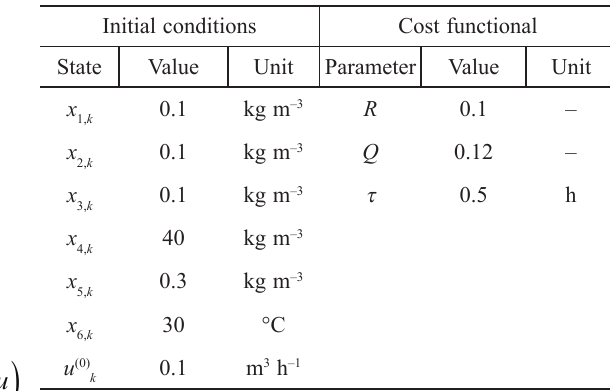
Table 1 – Parameter values